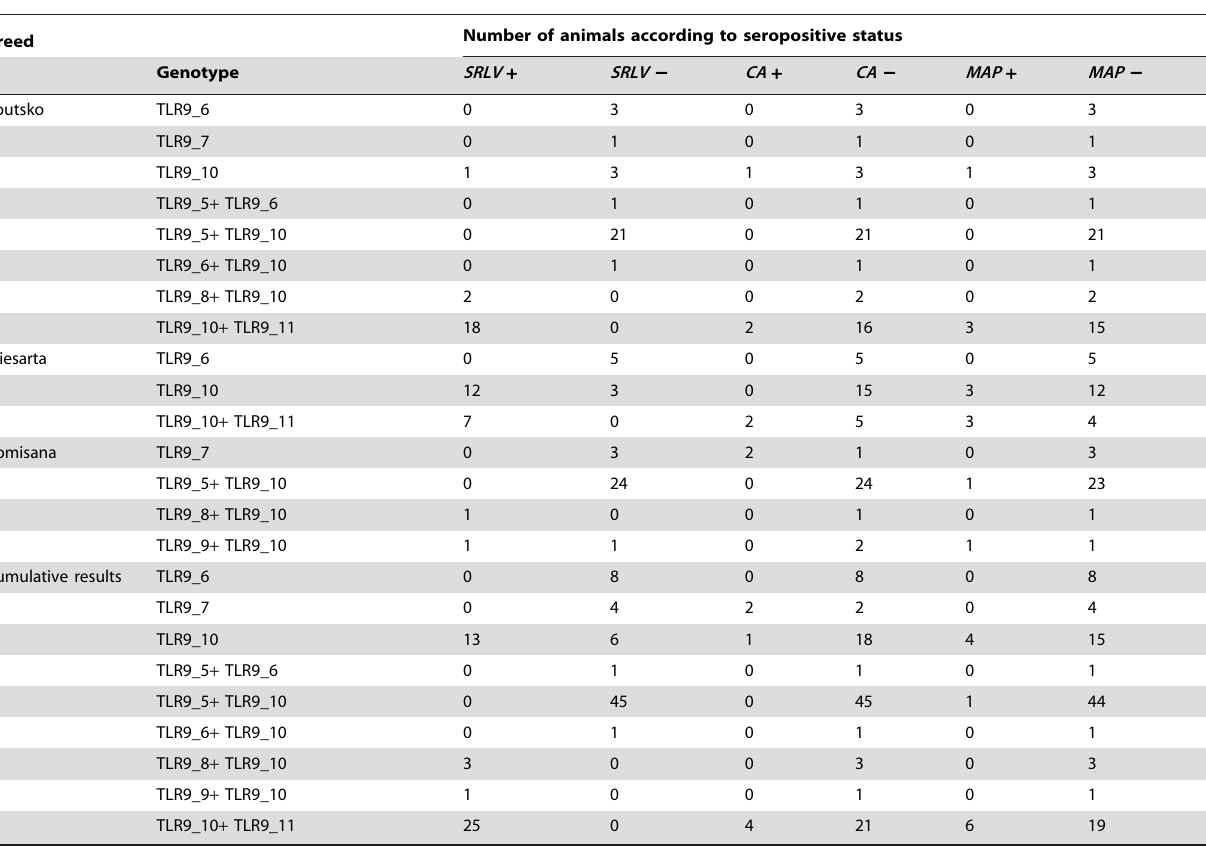
Table 4. Association of T LR9 genotypes with seroprevalence for Small Ruminant Lentivirus ( SRLV ), C. abortus ( CA ) or M. avium subsp. paratuberculosis ( MAP ) in three sheep flocks from different breeds.